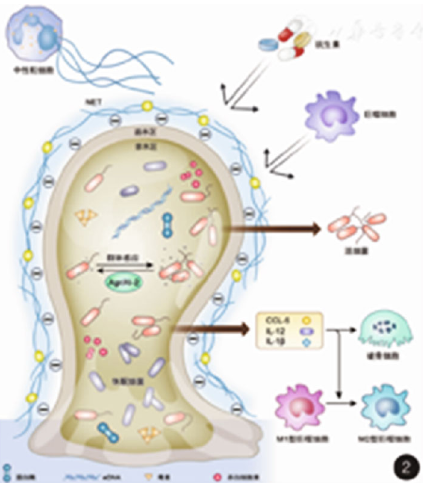
Figure 2: Toxin and genetic information transmission of bio fi lm in